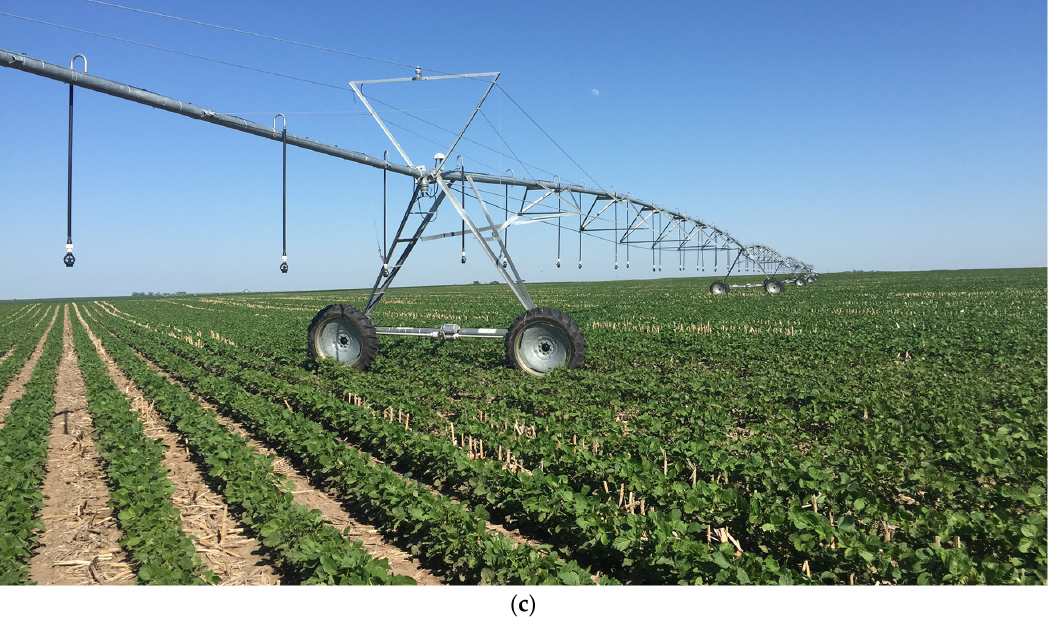
Figure 7. ( a ) Selected farm field; ( b ) Generating a customized profile of multiple variables for the selected location; ( c ) A photo of the selected farm filed.